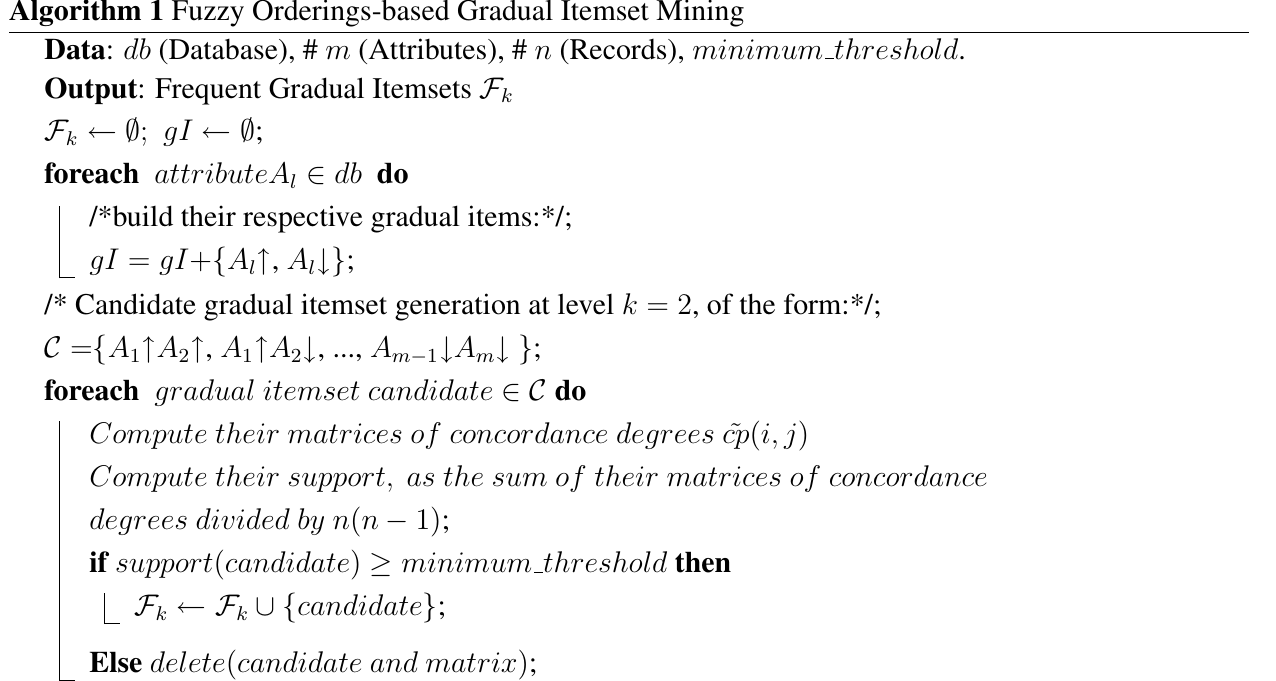
Algorithm 1 Fuzzy Orderings-based Gradual Itemset